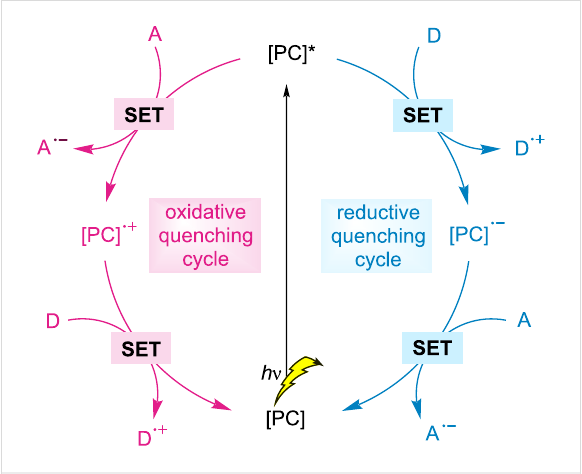
Figure 1: Oxidative and reductive quenching cycles of a photocatalyst. [PC] = photocatalyst, A = acceptor, D =